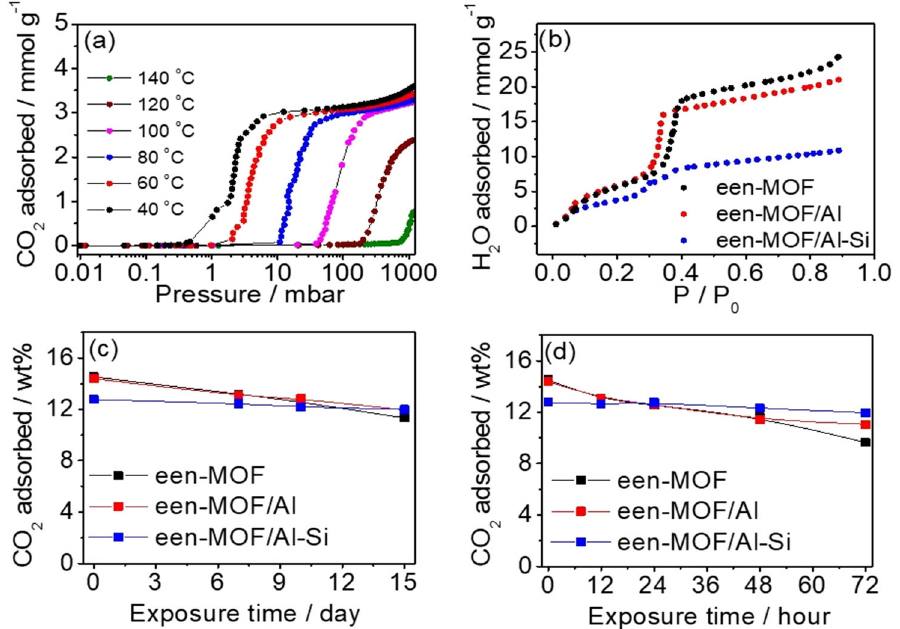
Fig. 4 Gas sorption behaviors and long-term stability test under humid condition. a Adsorption isotherms of CO 2 for een – MOF/Al – Si at various temperatures. b Water vapor isotherms of een – MOF, een – MOF/Al, and een – MOF/Al – Si. c CO 2 adsorption capacity of een – MOF, een – MOF/Al, and een – MOF/Al – Si after exposure to ambient air by using TGA. d CO 2 adsorption capacity of een – MOF, een – MOF/Al, and een – MOF/Al – Si after exposure to 10% H 2 O and 90% CO 2 at 140 °C by using TGA. The fl ow rate was 50 cc min − 1